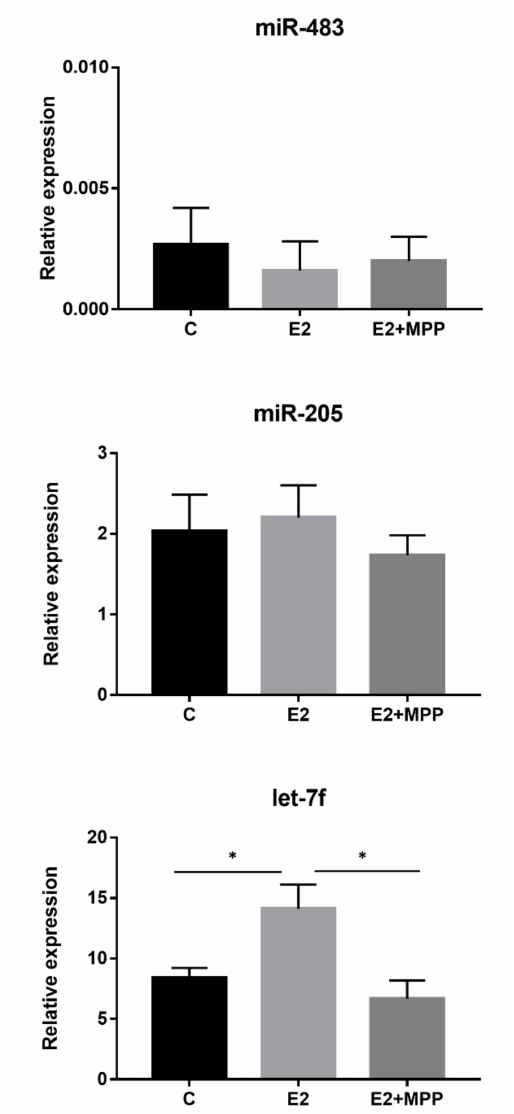
Figure 2. Relative expression levels of miR-483-5p, miR-205-5p, and let-7f-5p after the exposure to E2 and/or methyl-piperidino-pyrazole (MPP) in the PEO1 cell line. Relative expression was determined in the non-treated control (C) and E2-treated (E2) cells, as well as in those cells that were treated with MPP, together with E2 (E2 + MPP). Significance was determined by Student’s t -test between the ∆ CT values of the samples: * p <